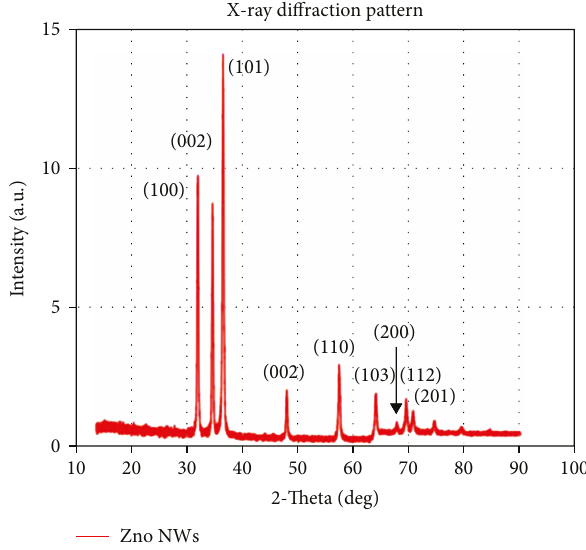
Figure 5: X-ray di ff raction pattern of ZnO nanowires, con fi rming both elemental composition and high